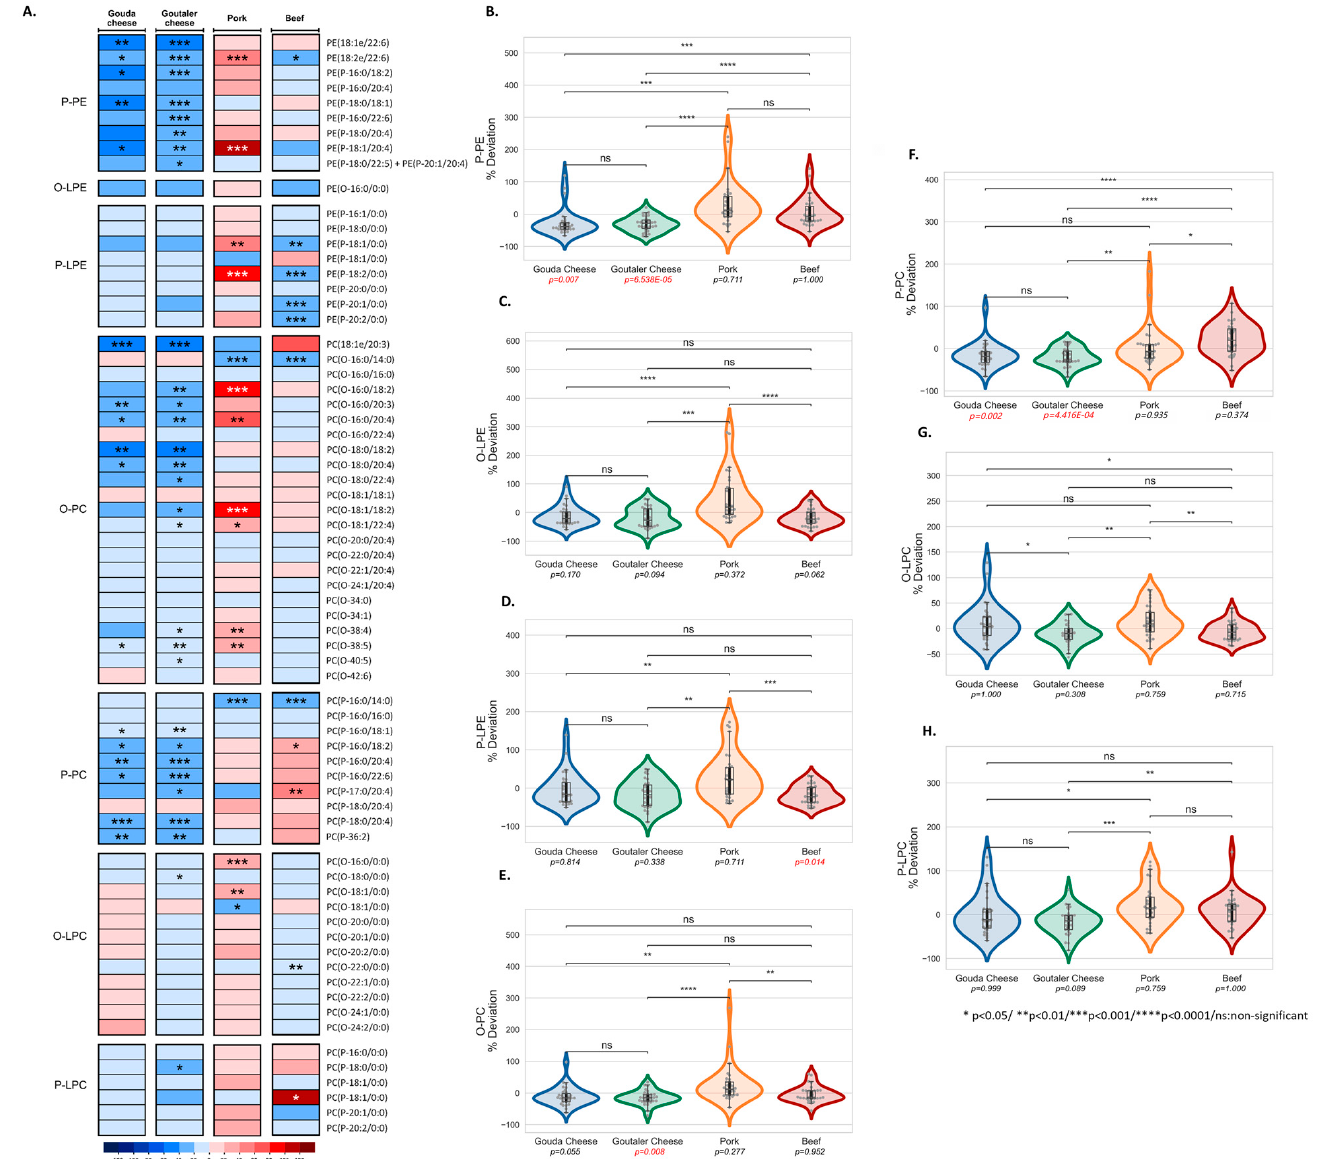
Figure 4. Heatmap representing the results (median ± SD of the percentage of change post- versus pre-intervention values) of the ether lipids from the lipidomic analysis for the four test diets (Gouda- and Goutaler-type cheeses, pork, and beef) ( A ). Comparisons between test diets for lipid classes ( B – H ). Abbreviations: phosphatidylethanolamines (PEs); ether-linked PE (O-PE); vinyl–ether-linked PE (P-PE); lysoPE (LPE); ether-linked LPE (O-LPE); vinyl-ether-linked LPE (P-LPE); phosphatidylcholine (PC); ether-linked PC (O-PC); vinyl-ether-linked PC (P-PC); lysophosphatidylcholines (LPCs); ether ‐ linked LPC (O ‐ LPC); vinyl ‐ ether ‐ linked LPC (P ‐ LPC).